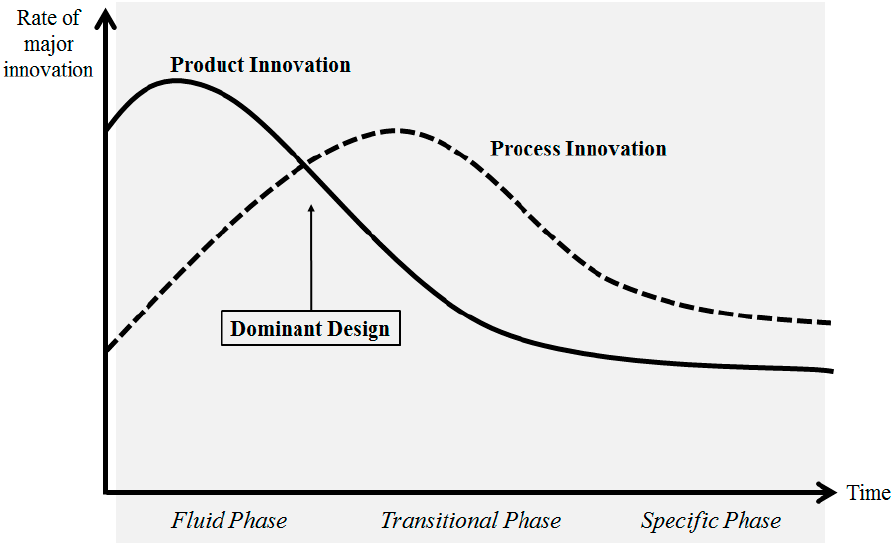
Figure 1. The rate of product and process innovation depending on industry maturity (Source: Abernathy and Utterback, [1]). 75